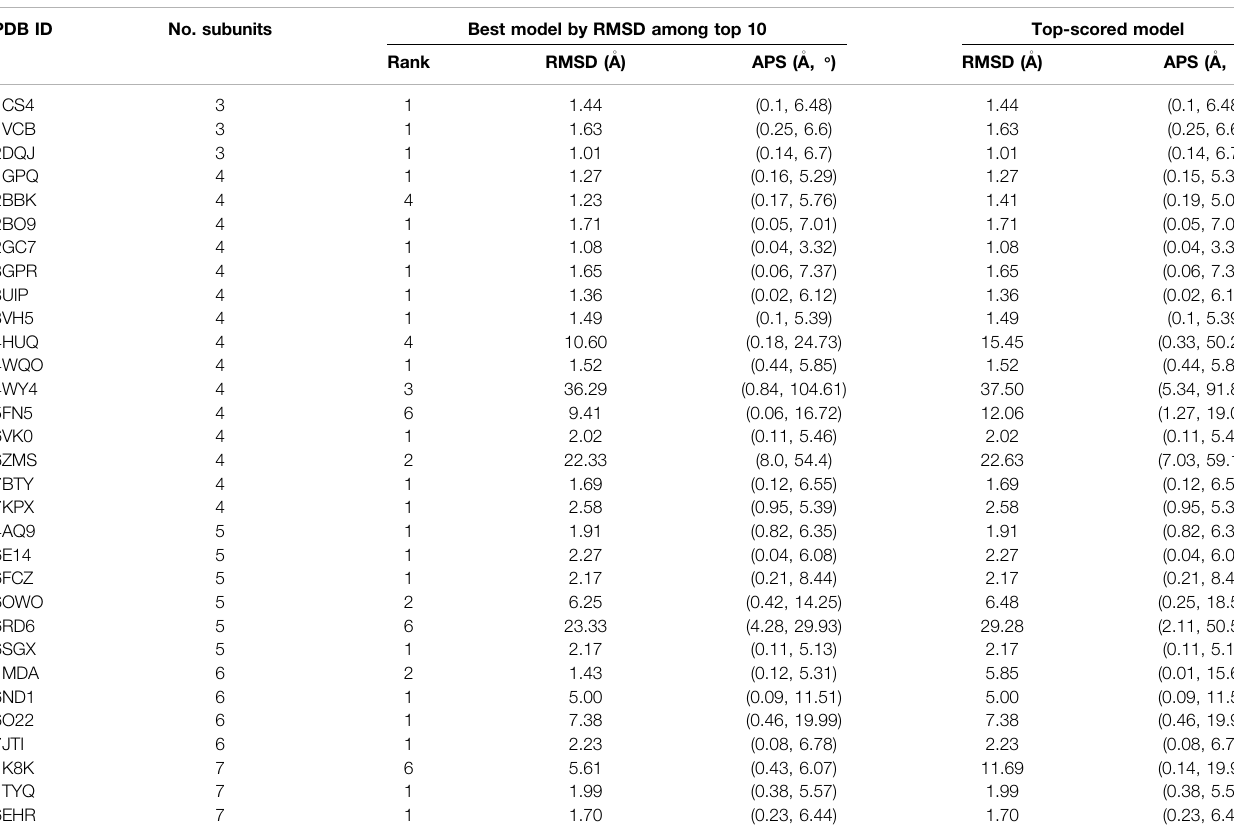
TABLE 1 | Modeling accuracy in the simulated dataset. PDB ID No. subunits Best model by RMSD among top